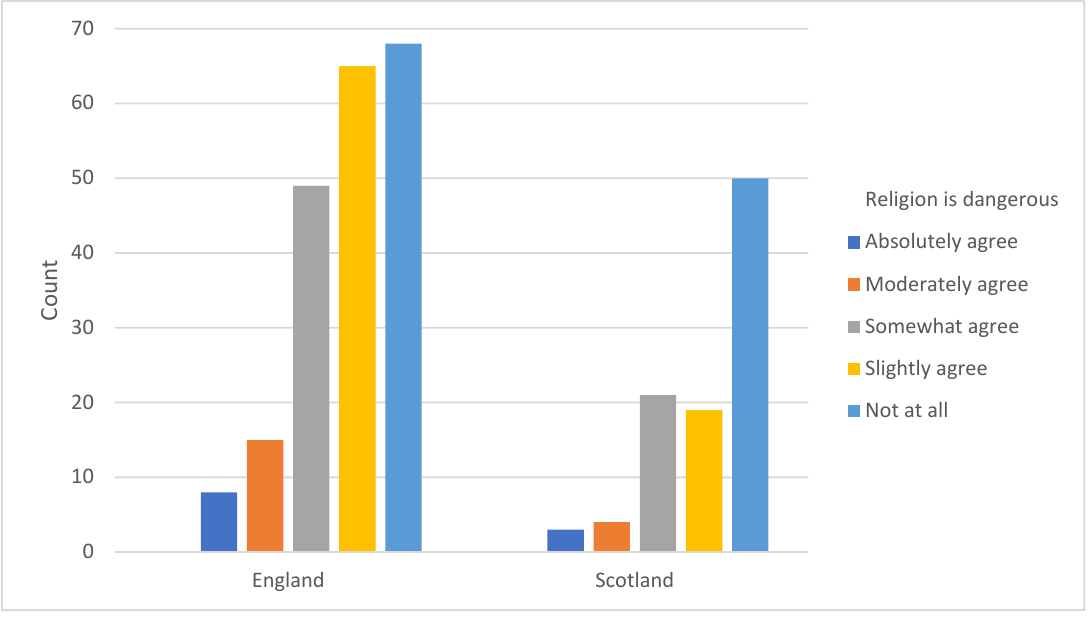
Figure 8. Q23 Religion is Dangerous (England, Scotland and Secondary only): n = 30.